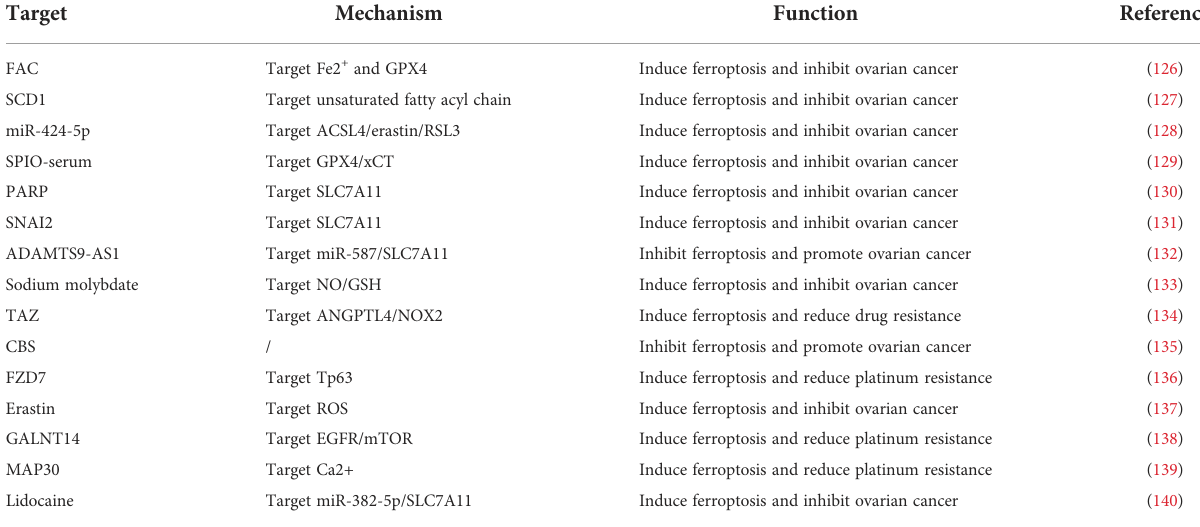
TABLE 1 The regulatory role of ferroptosis related genes in ovarian cancer progression.